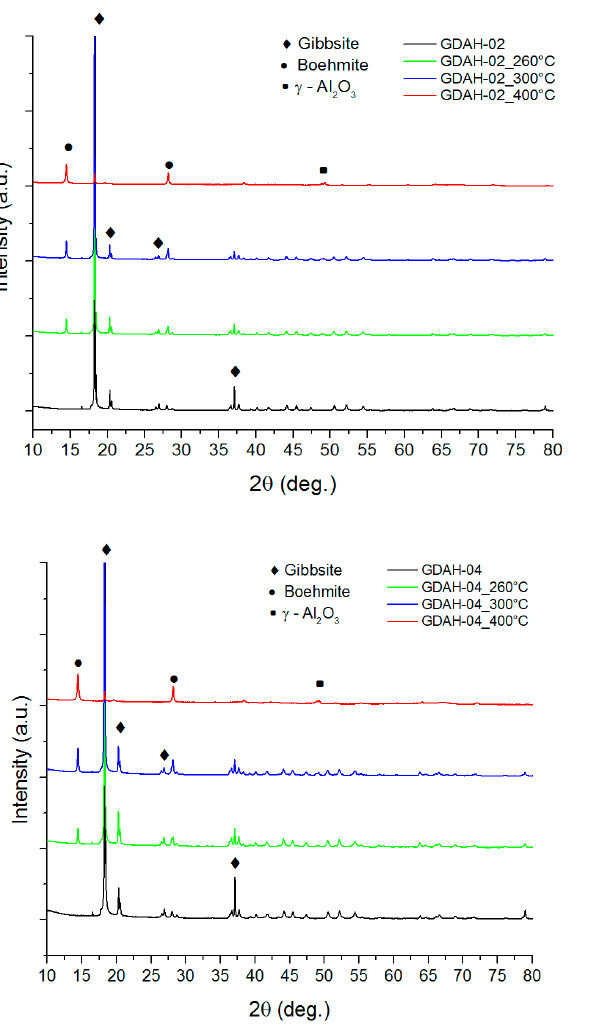
Figure 2. X-ray diffraction patterns for all samples.